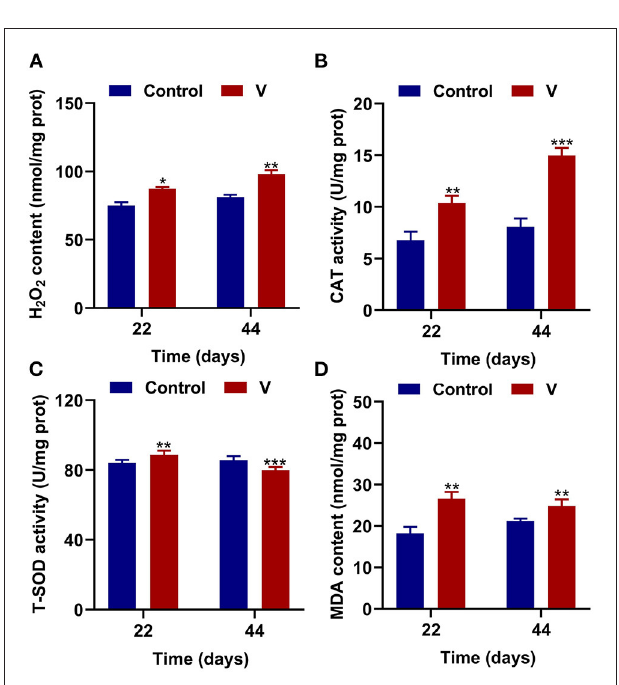
FIGURE 2 | V induced oxidative stress in the heart of ducks. (A) H 2 O 2 content. (B) The activity of CAT. (C) The activity of T-SOD. (D) MDA content. Data are represented as mean ± SD ( n = 6 per group). “*” Indicates significant difference compared with the corresponding control (* p < 0.05, ** p < 0.01, and *** p <